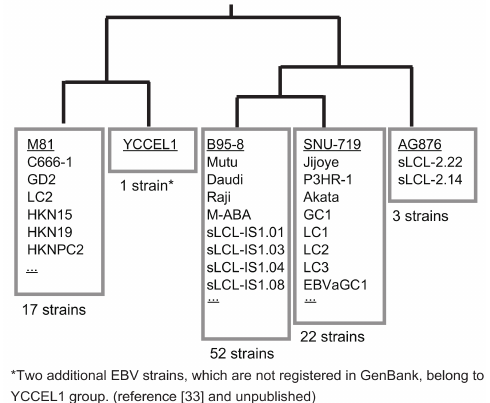
Figure 3. EBV strains can be categorized into five groups based on homology arm sequences. The sequences of 1088-bp SacI fragments of representative EBV strains (AG876, SNU-719, B95-8, YCCEL1, and M81) were subjected to phylogenetic tree analysis (CLUSTALW) and BLAST searches to find out how this region is conserved among various EBV strains. The numbers of EBV strains whose SacI fragment was 100% identical to that of the representative EBV strains are indicated. Only the EBV strains with correctly annotated BVRF1 and BVLF1 genes are taken into